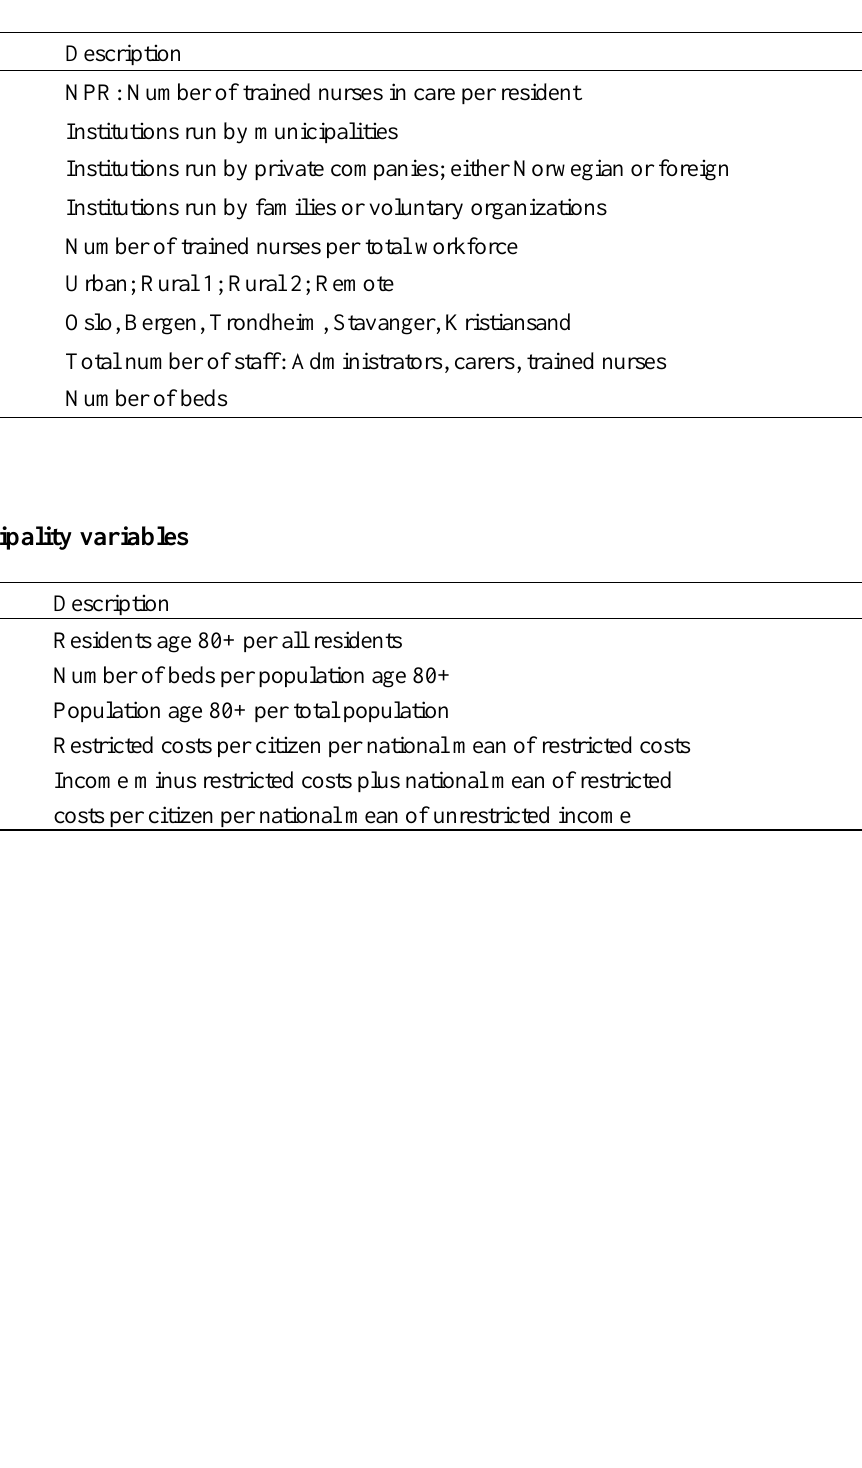
Table A1: Institutional variables